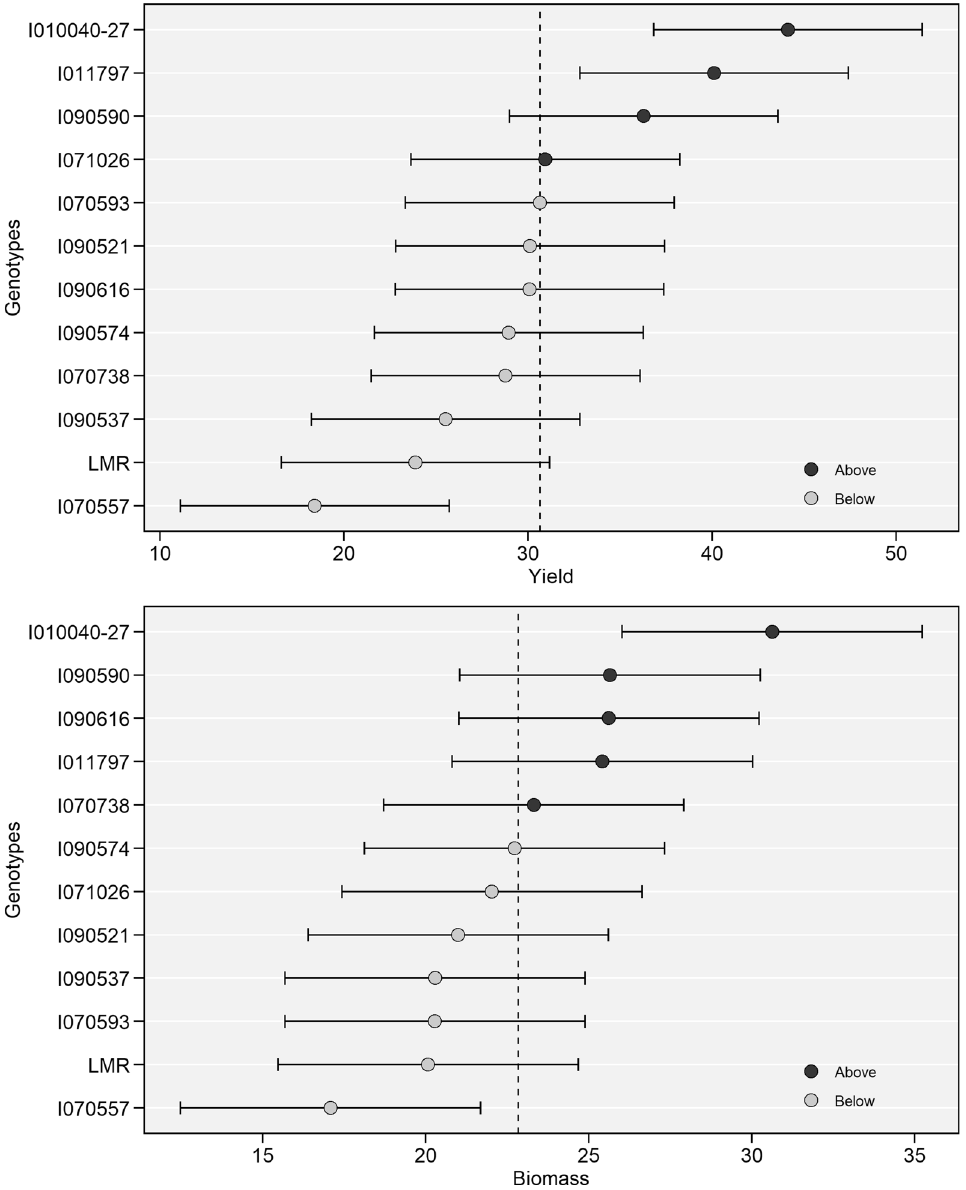
Figure 3. Best linear unbiased prediction for biomass ( A ) and fresh root yield ( B ) for 12 genotypes. Black and grey circles represent the genotypes that had BLUP above and below of BLUP mean, respectively. Horizontal error bars represent the 95% confidence interval of a prediction considering a two-tailed t test. (R V3.6.2, https:// cran.r- proje ct. org/ web/ packa ges/